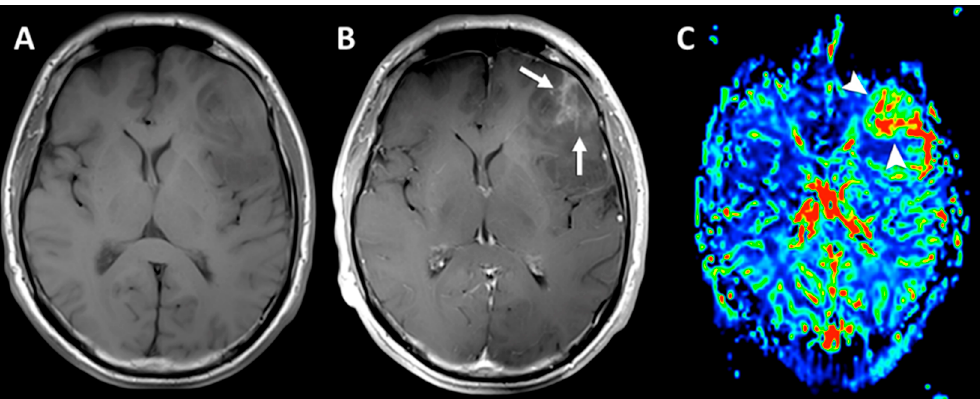
Figure 2. Axial T 1 -weighted ( A ) post-contrast axial T 1 -weighed FSE acquisition. ( B ) A focal region of heterogeneous enhancement (white arrows) indicating disruption of the blood–brain barrier, a finding usually seen in malignant gliomas. Dynamic susceptibility contrast (DSC) perfusion images were also acquired. During the first pass, a Gd-based CA to explore the T 2 * effects and post-processed rCBV map ( C ) demonstrates a focal area of markedly increased tumor vascularity (arrowheads) matching the area of enhancement. This area was targeted for stereotactic biopsy, which confirmed the suspicion of an anaplastic glioma. Reproduced with permission from [6].